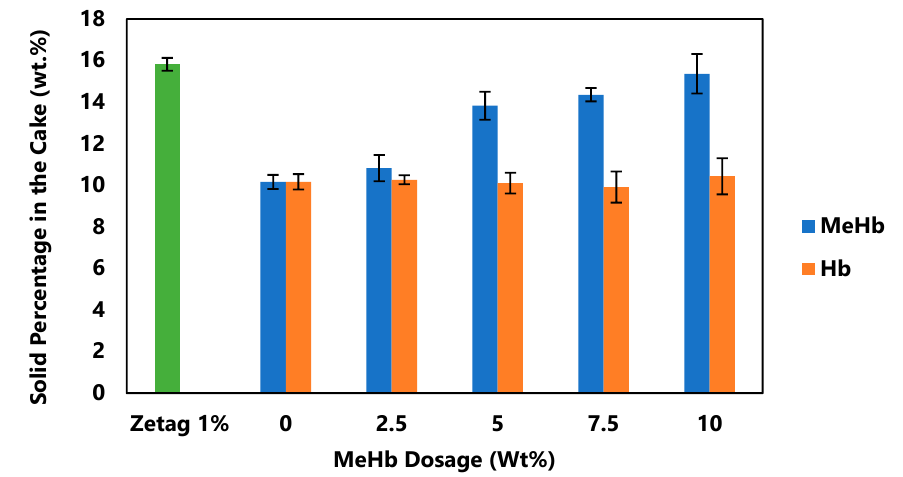
E ff ect of hemoglobin and methylated hemoglobin on cake dry solids content at Figure 2. Effect of hemoglobin and methylated hemoglobin on cake dry solids content at different di ff erent dosages.